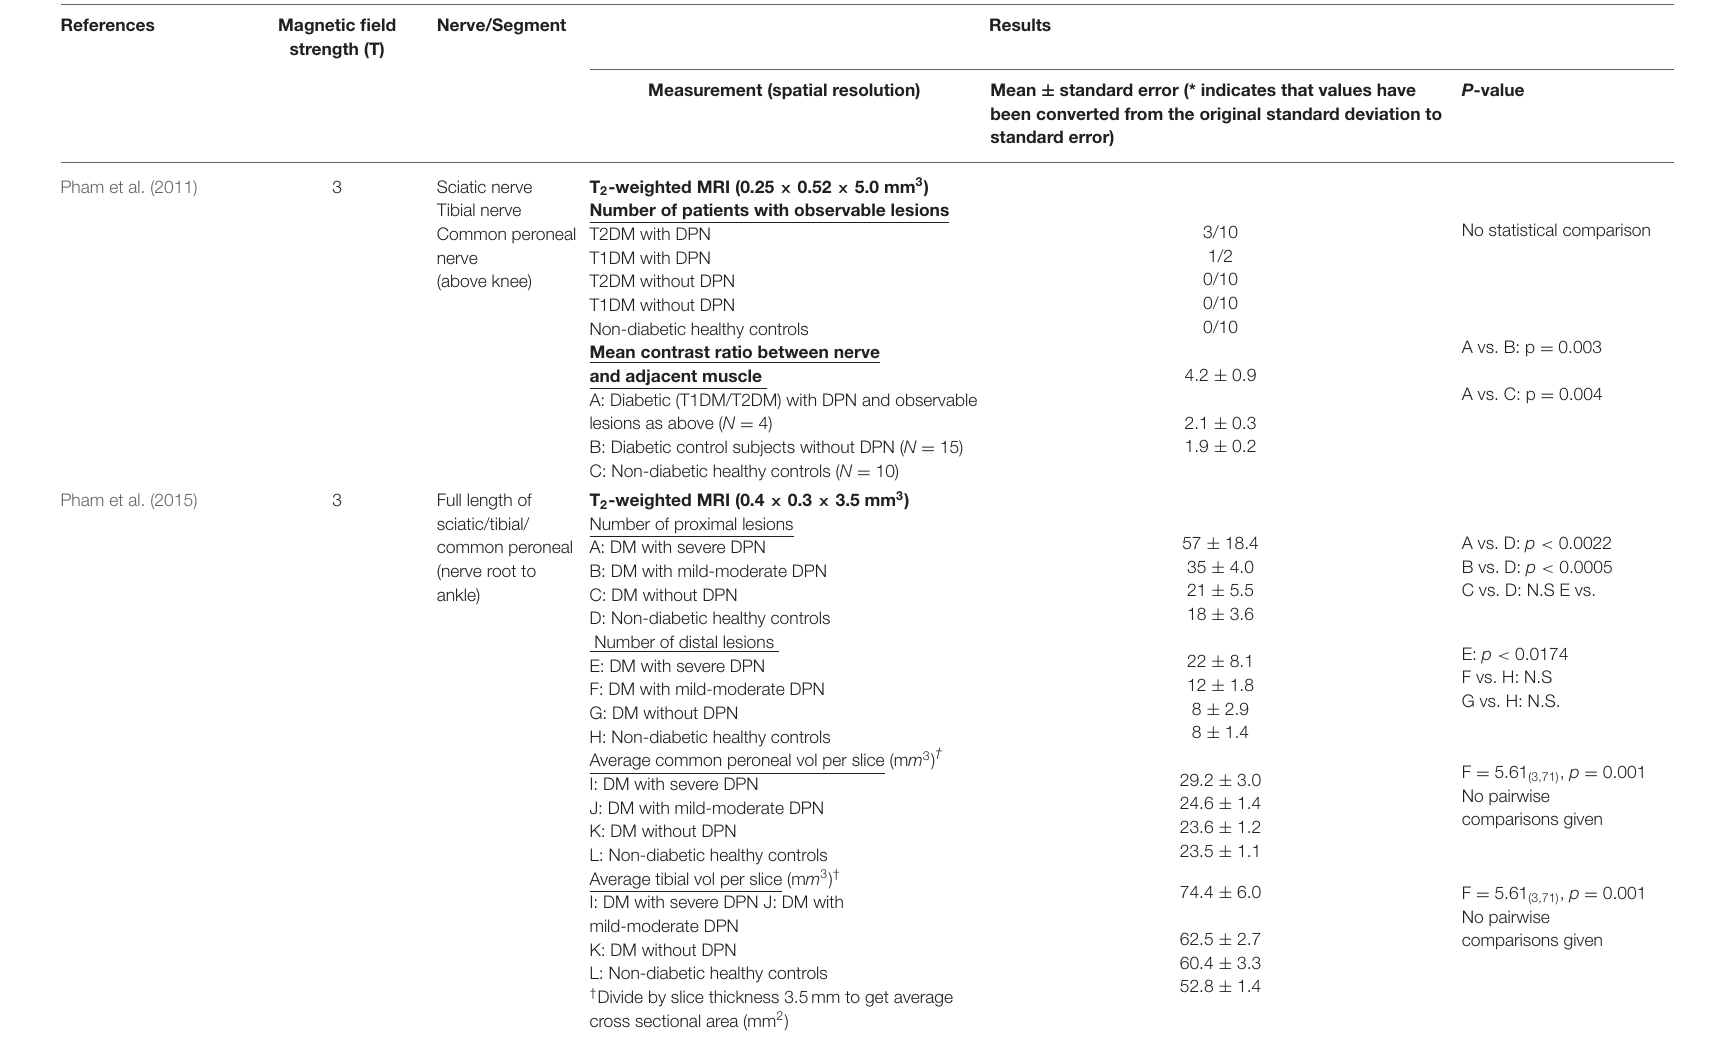
Mean ± standard error (* indicates that values have been converted from the original standard deviation to